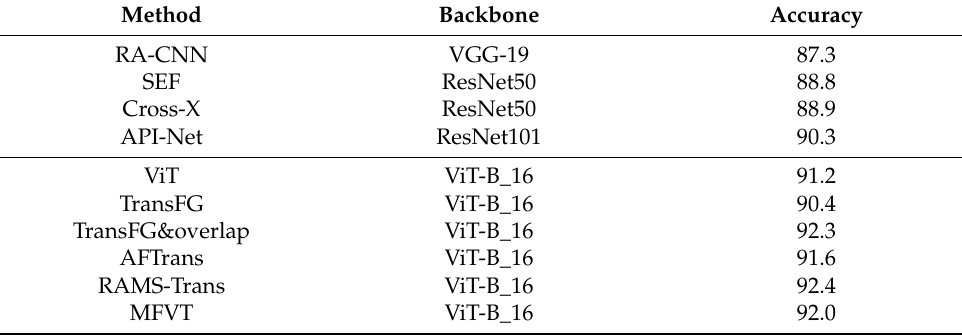
Table 9. Accuracy of different methods on Stanford